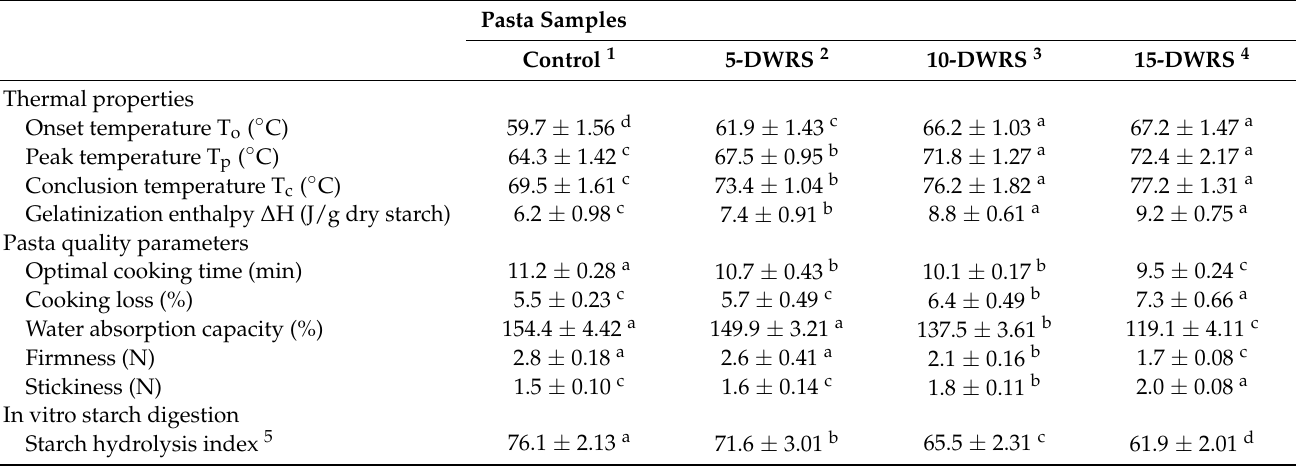
Table 3. Thermal properties and quality parameters of semolina spaghetti containing resistant starch (RS) from debranched waxy rice starch (DWRS). Pasta Samples Control